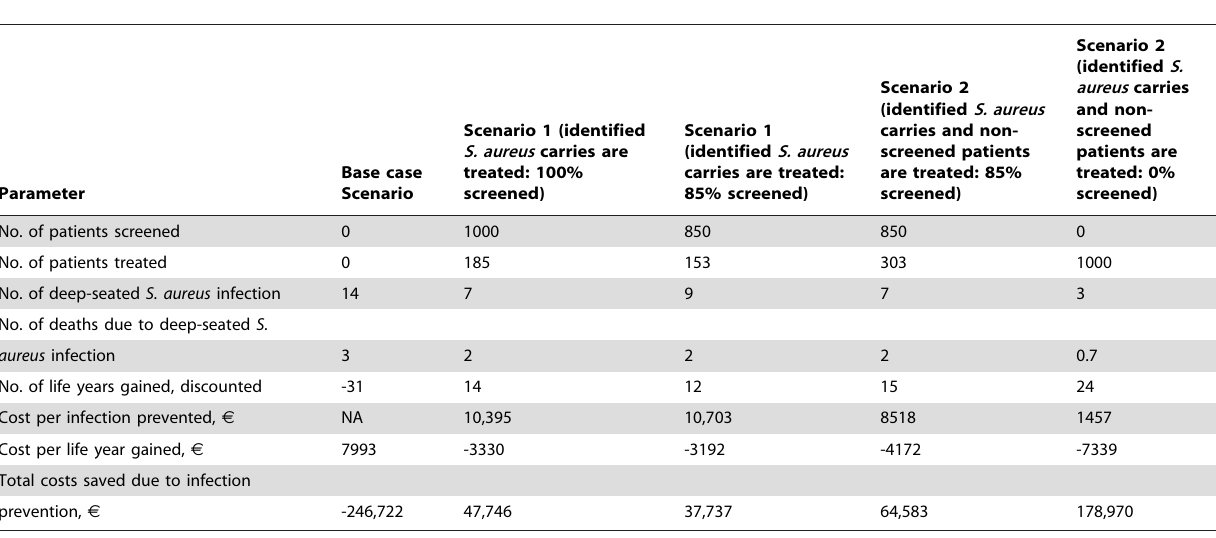
Table 4. Cost-analysis of different strategies per 1000 patients undergoing prosthetic joint or cardiopulmonary surgery.